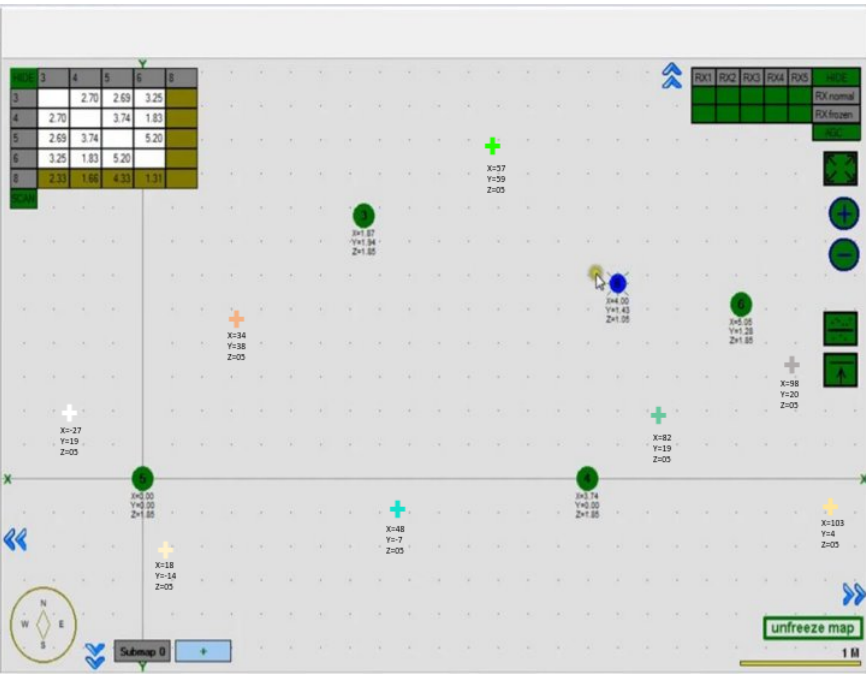
Figure 12. Structural defects ( a – c ), degradation in the HVAC system ( d , e ), infestation ( f , g ), and electrical damage ( h ) during online testing.